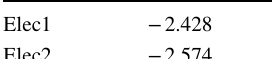
Table 6 The transformation value of